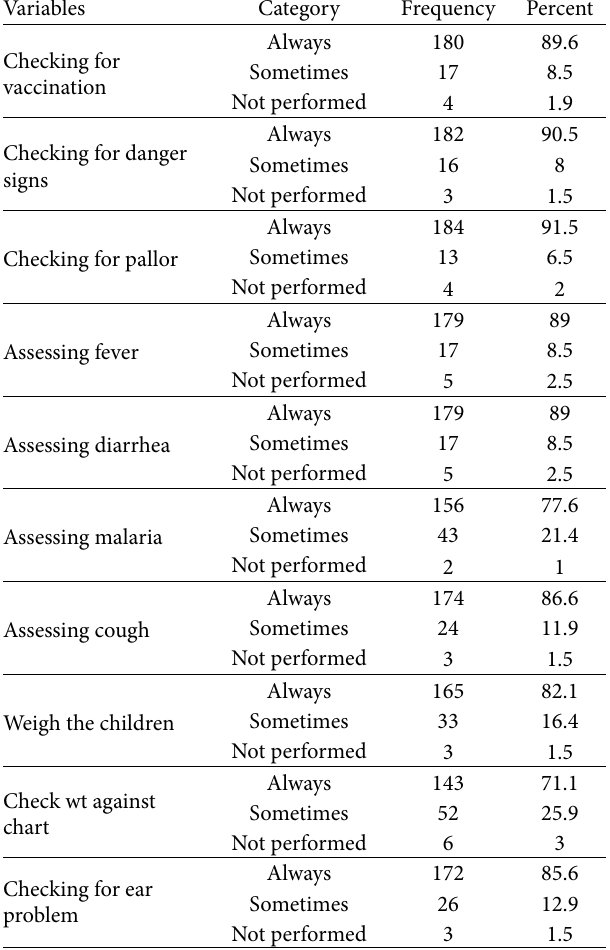
Table 6: IMNCI activities performance of the study participants.